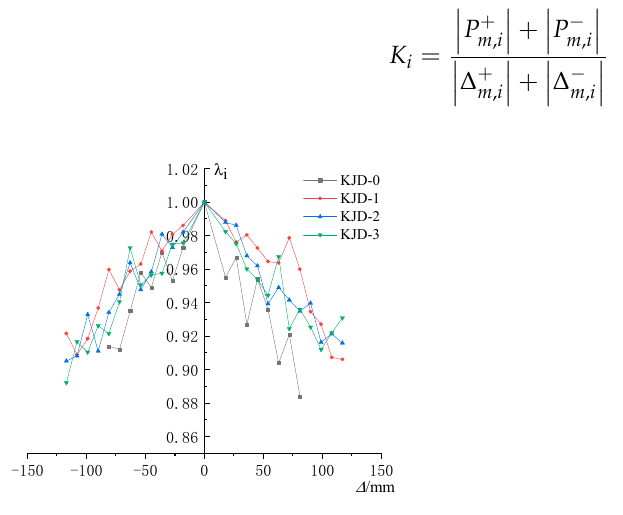
Figure 12. Strength degradation curves.